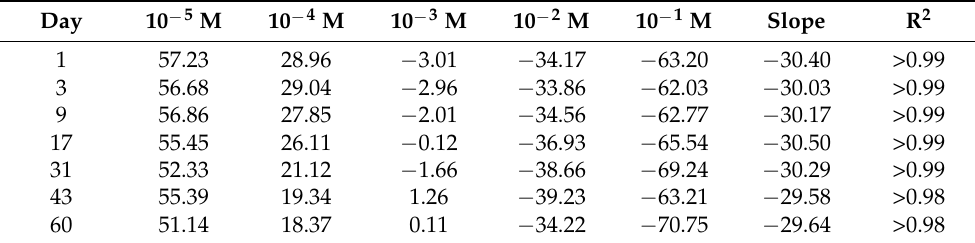
Table 1. Performance of the ISE (mV) in the range of 10 − 5 –10 − 1 M Na 2 CO 3 over 60 days.